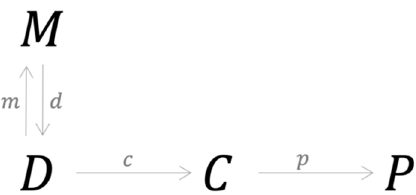
Figure 8. A category of model combination based on a stacking process that avoids the equivalent trap.